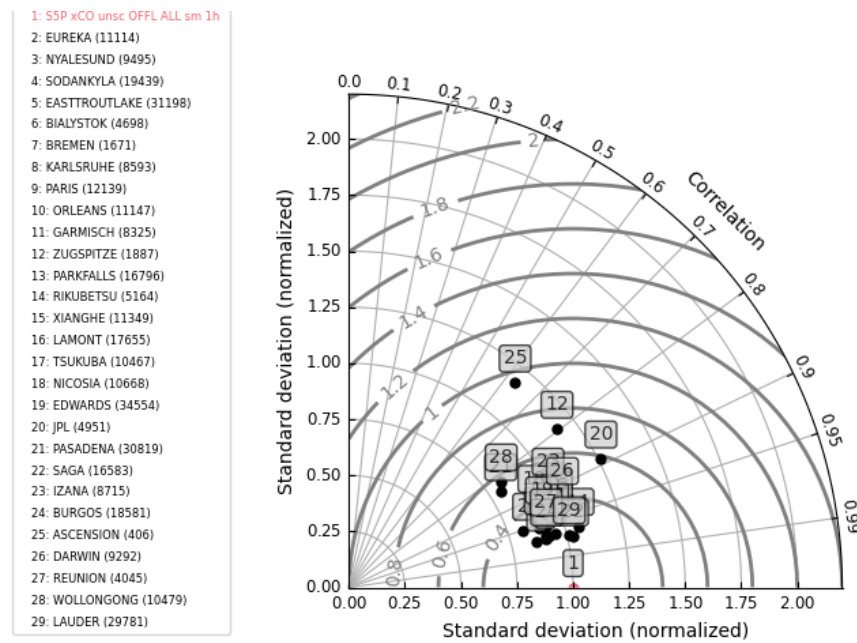
Figure 24. Taylor diagram for daily mean differences between S5P and TCCON unscaled XCO data with a priori alignment at 28 TCCON stations within the period between November 2017 and September 2020. Spatial co-location with radius of 50km and time of ± 1h around the satellite overpass was used. The stations are sorted with decreasing latitude.